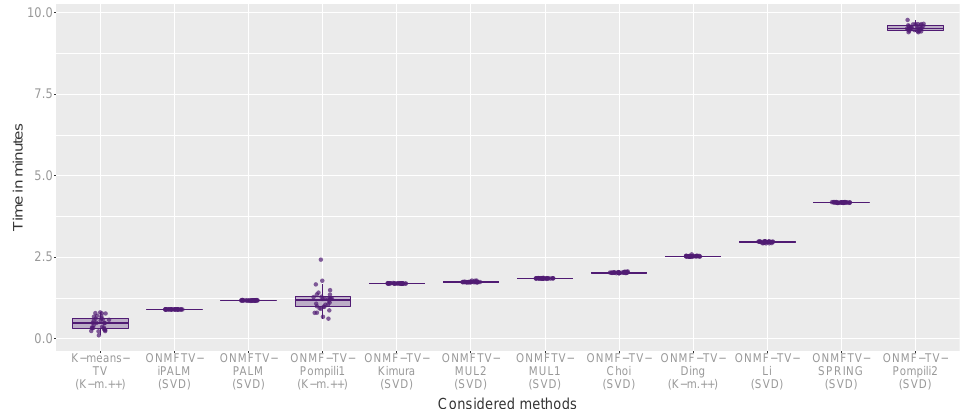
Figure 6. Box plot of the computational times in minutes of all performed